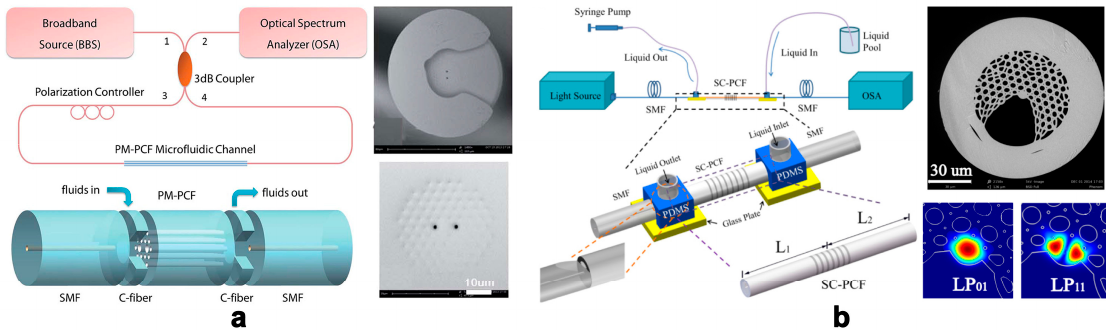
Figure 1. ( a ) Scheme and transverse section graph of the SMF-C-PCF-C-SMF microfluidic device. Reprinted with permission from [30]. Copyright (2014) RSC; ( b ) Scheme of the in-line optofluidic sensing platform and SEM image of the SC-PCF and Simulated intensity distribution of LP 01 mode and LP 11 mode at the wavelength of 1550 nm. Reprinted with permission from [31]. Copyright (2016)